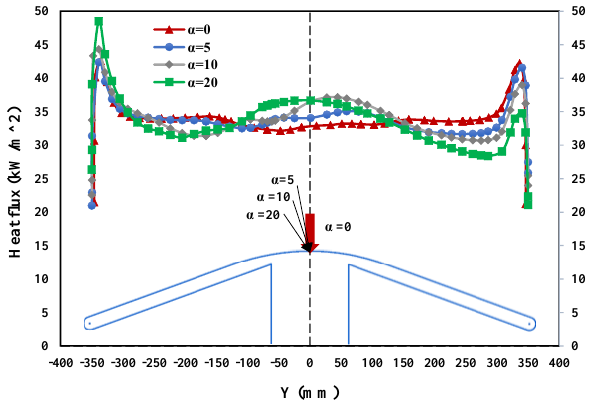
Figure 19. Heat flux distribution of changing α .